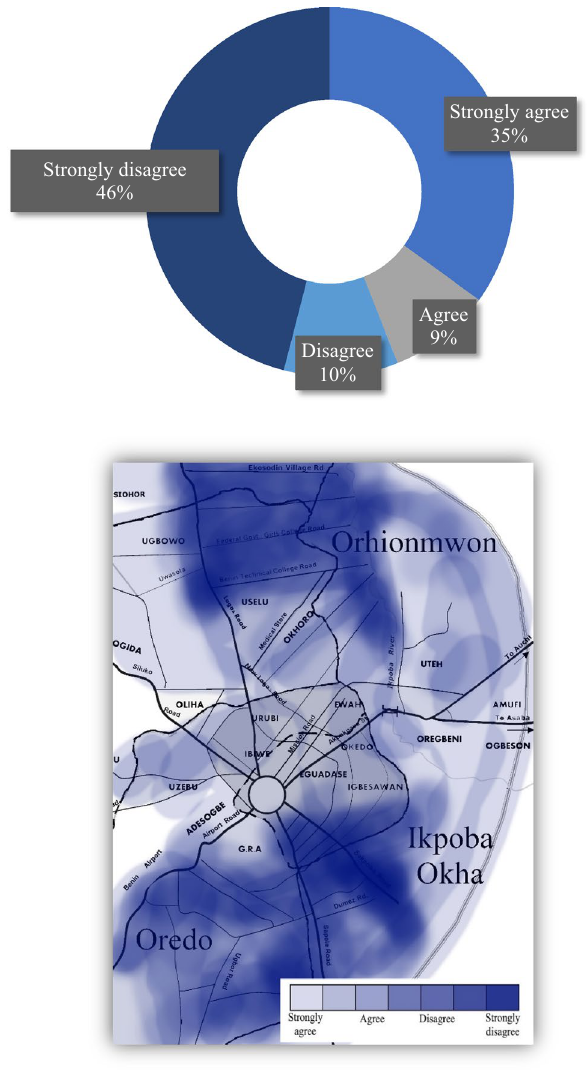
Figure 2. Perception that there is growing threat level from MSW disposal in Benin City: (top) graph, (bottom) mapped